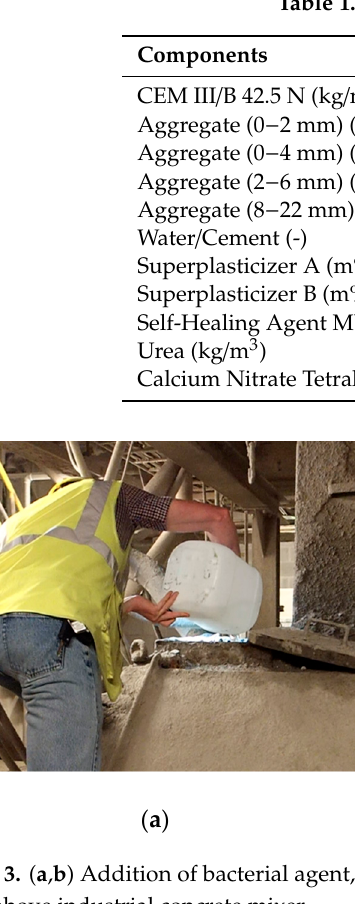
Figure 3. ( a,b ) Addition of bacterial agent, urea and calcium nitrate tetrahydrate through inspection hatch above industrial concrete mixer. Table 1. Concrete